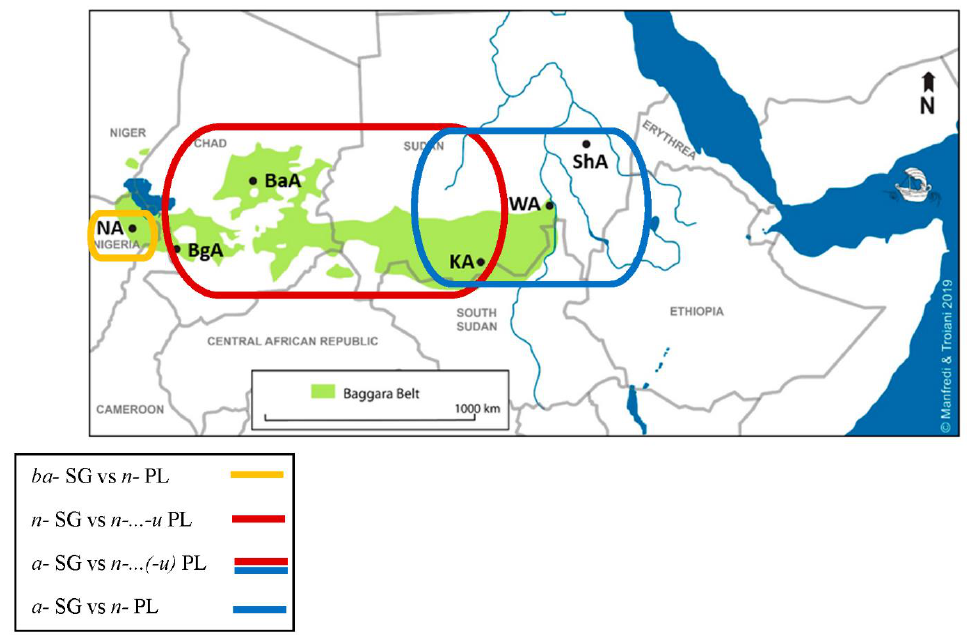
Sudan. Figure 6 resumes the distribution of the pronominal prefixes of the prefixed conjugation across the Baggara Belt. Table 3. 1SG/1PL marking in prefixed conjugation.